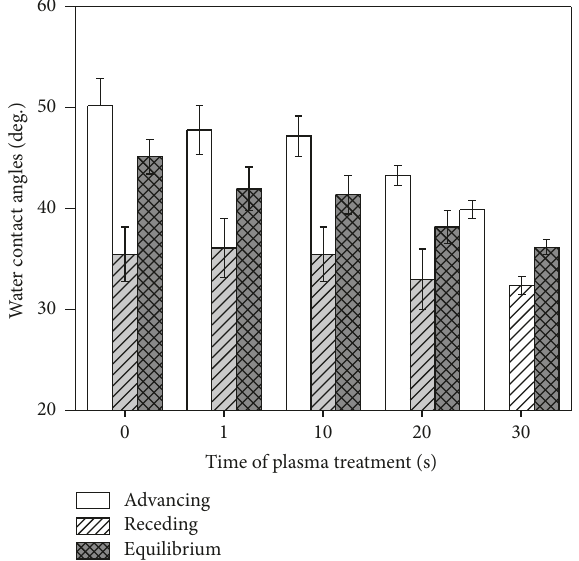
Figure 4: Advancing and receding diiodomethane contact angles measured on the paper composite surface.